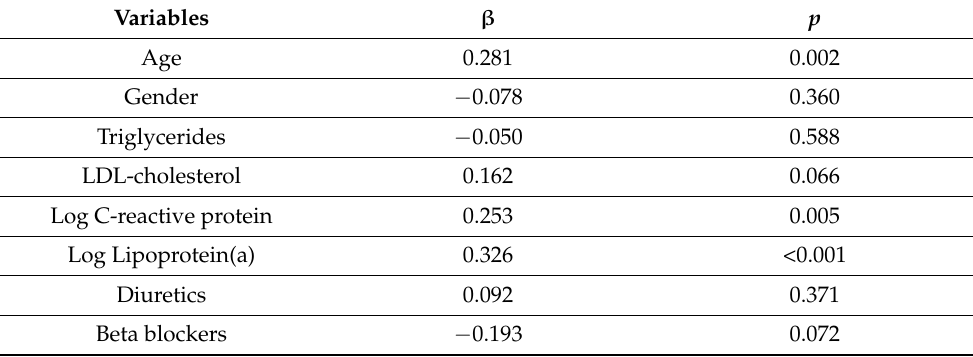
Table 4. Multivariate analysis with the pulse wave velocity as the dependent variable.